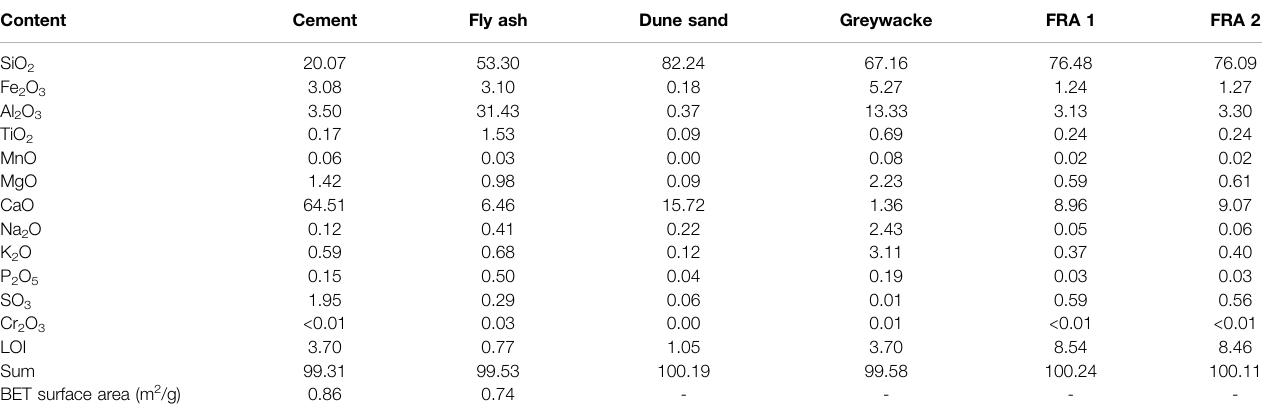
TABLE 3 | Oxide composition and relevant physical properties. Content